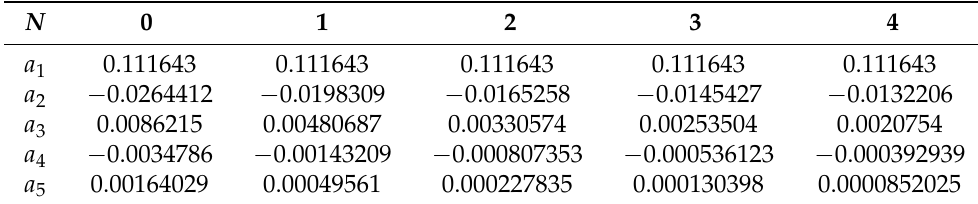
Table 1. Coefficients a n of the loop expansion c 1 ( x ) for the number of components N .